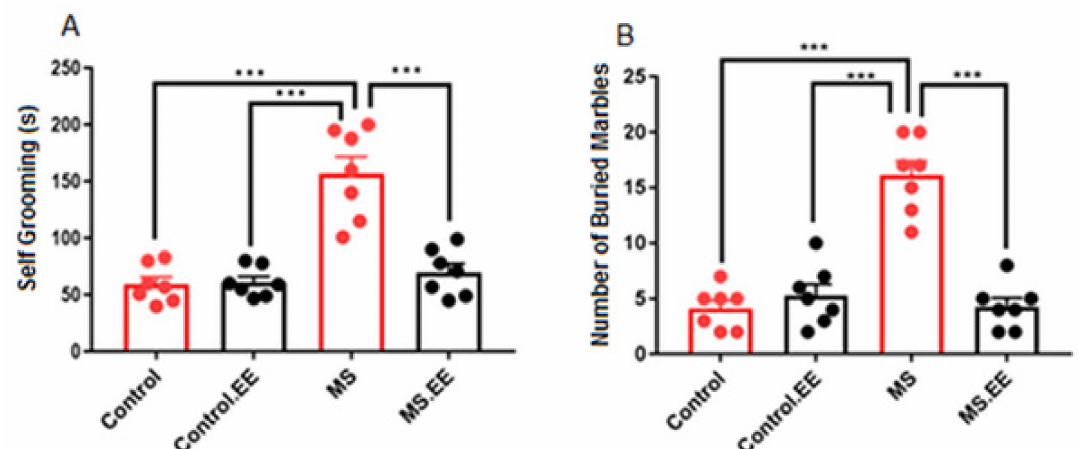
Figure 1. Effects of maternal separation and EE on the stereotypic behaviors. ( A ): self-grooming, ( B ): marble burying. *** p < 0.001. N = 10 in each group. Data are presented before log-transformation, MS: Maternal Separation, EE: Environ- mental Enrichment.